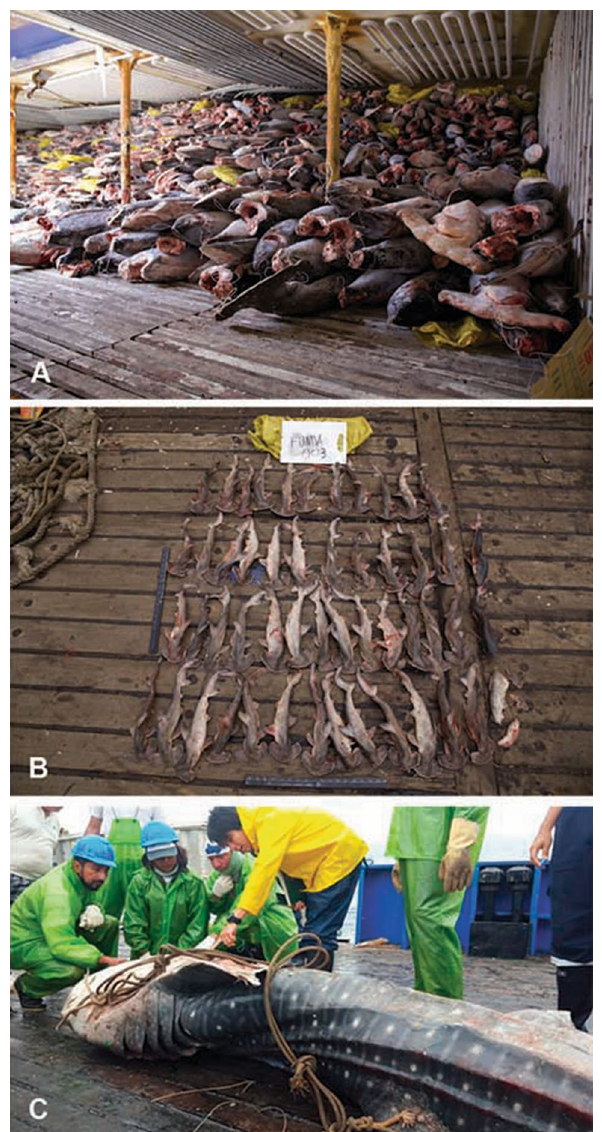
Figure 1. Sample of shark carcasses seized in vessel Fu Yuan Yu Leng 999. A, inside one of the vessel freezers. B, unborn scalloped hammerhead sharks; C, whale shark. We assembled this figure using Adobe Creative Suite (https:// www. adobe.